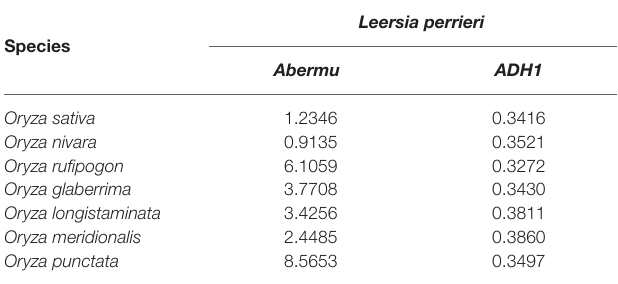
( Figure 6 ) affects the gene expression in barley and the functional divergence of the orthologous genes. The